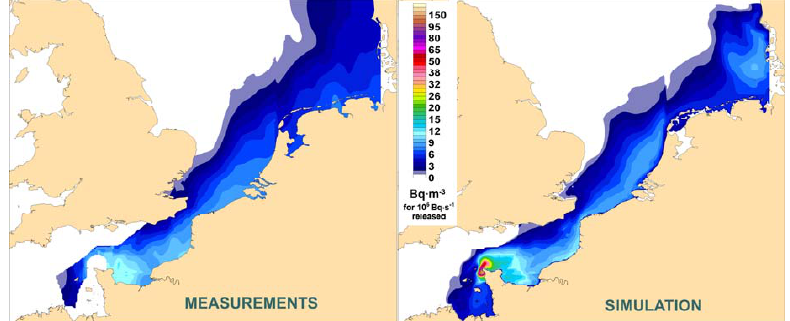
Figure 14. Normalized measured and simulated distribution of 125 Sb between 1988 and 1994 for a constant release of 10 6 Bq ∙ s − 1 , adapted from [24].